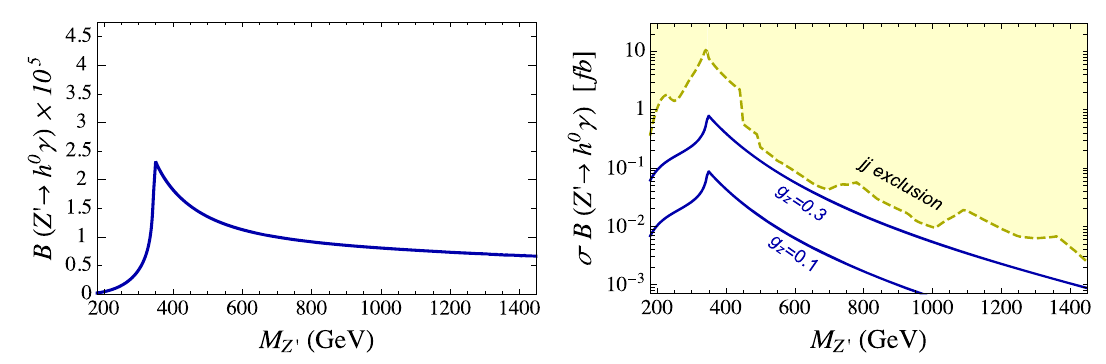
Fig. 3 Left panel The Z (cid:2) → h 0 γ branching fraction as a function of the Z (cid:2) mass, when the Z (cid:2) has flavor-universal vector couplings to the SM quarks, and there are no new particles running in the loop. Right panel Leading-order pp → Z (cid:2) → h 0 γ cross section at